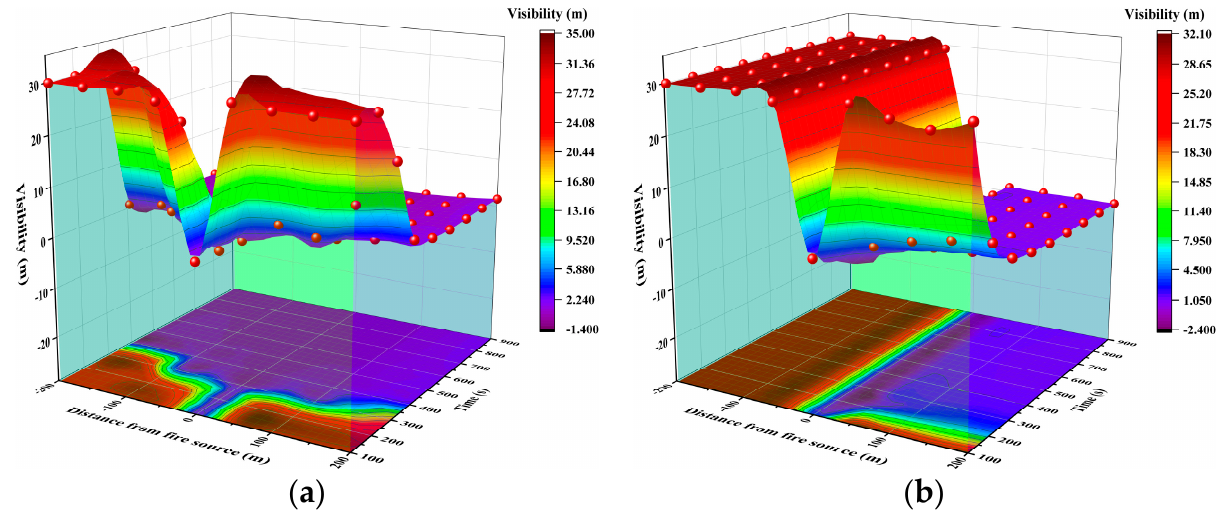
Figure 11. 3D curves of visibility with time and distance: ( a ) 0.5 m/s; ( b ) 3.6 m/s. V changed with distance from the fire source when the longitudinal ventilation velocity was 0.5 m/s. After 200 s, the visibility in the whole tunnel was below the critical value. A fire with 3.6 m/s velocity had very different visibility distributions on the left and right sides. After 200 s, visibility was almost entirely below 10 m downstream and above 10 m upstream. Within 300 s after the fire, it was almost impossible to see downstream.